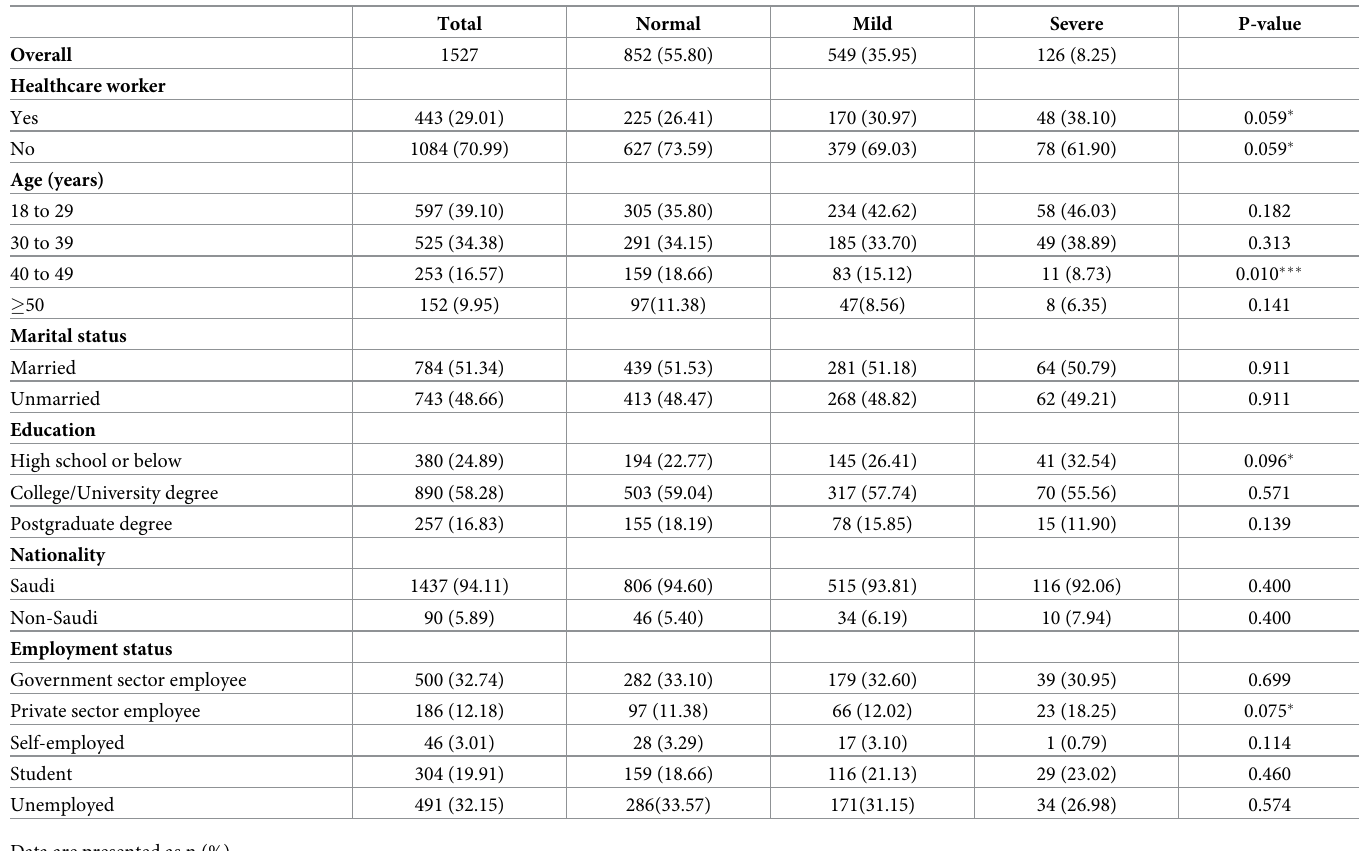
Table 1. Sociodemographic characteristics of the study sample (N = 1527). Total Normal Mild Severe